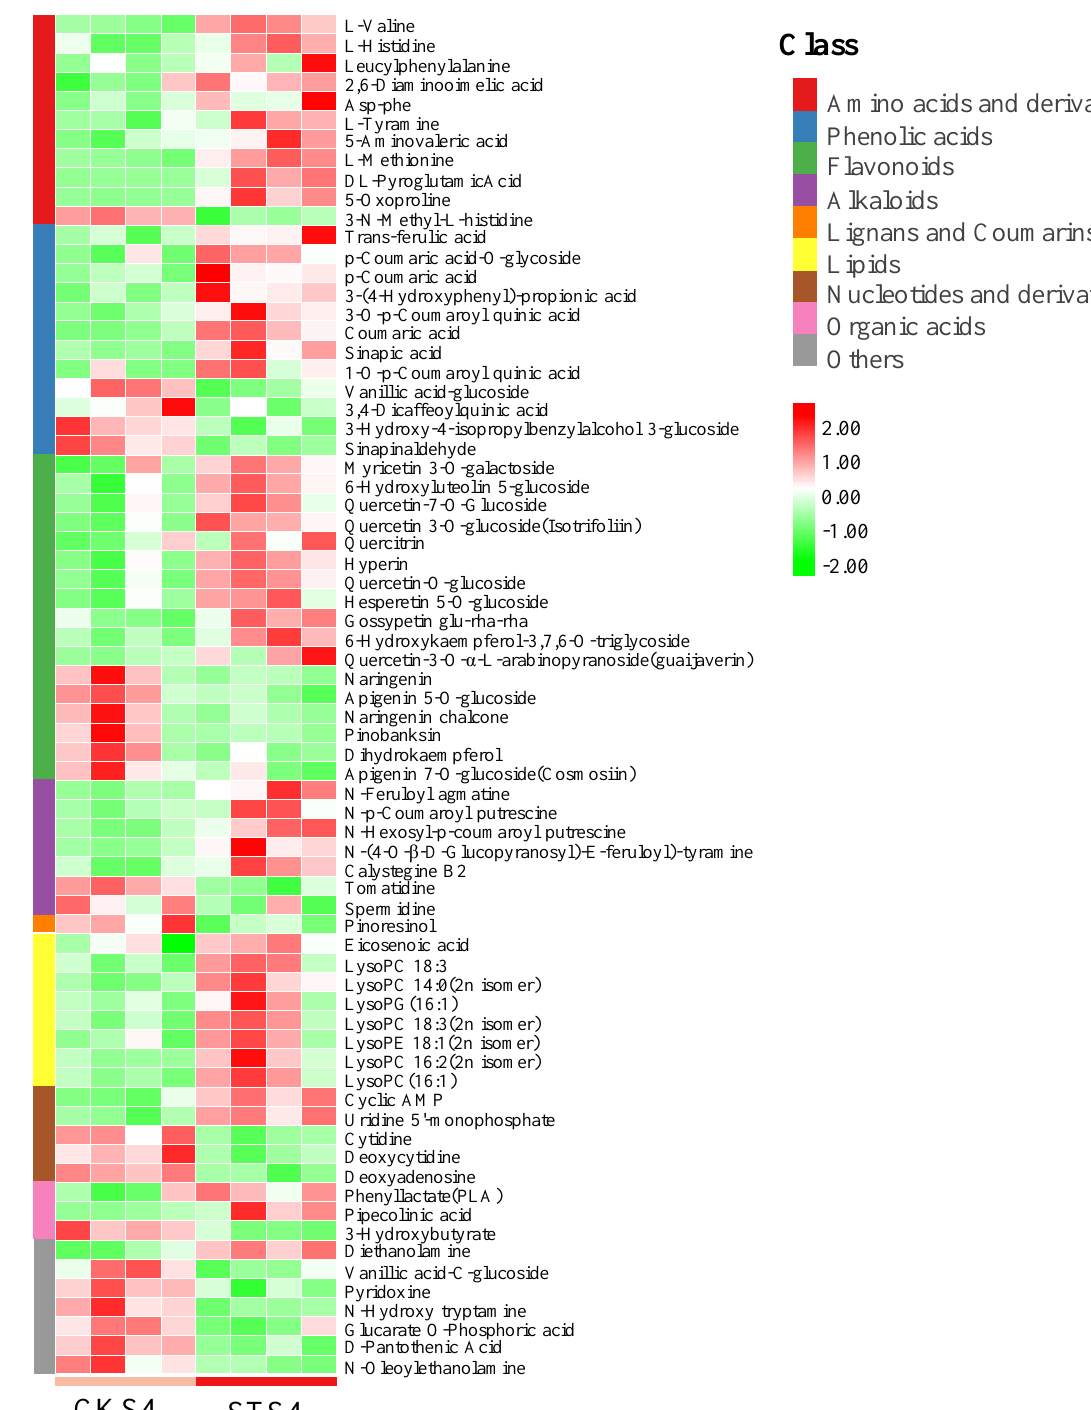
Figure 2. The profile of differentially accumulated metabolites (DAMs) in Lycium barbarum fruit. S4 fruit indicate that fruit was collected at ripe stage. ST and CK refer to fruit treated with and without 300 mM of NaCl, respectively. Metabolites with VIP > 1 and fold change >1.5 or <0.67 were defined as DAMs. The color key indicates the relative content of metabolite of low to high levels from green to red.